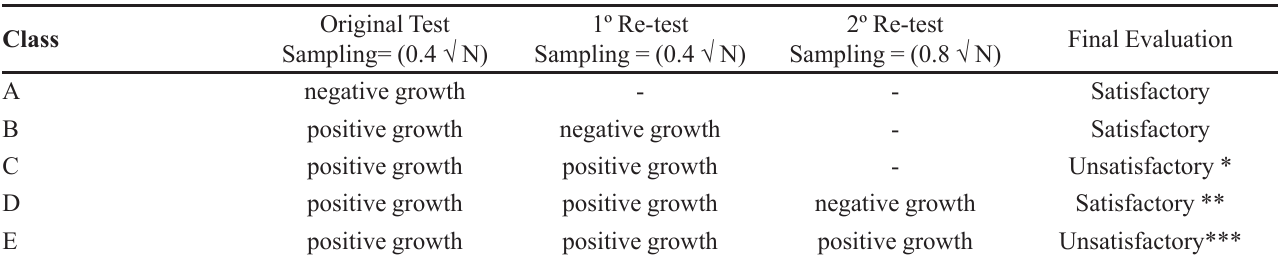
TABLE VI - Interpretation of the sterility test data